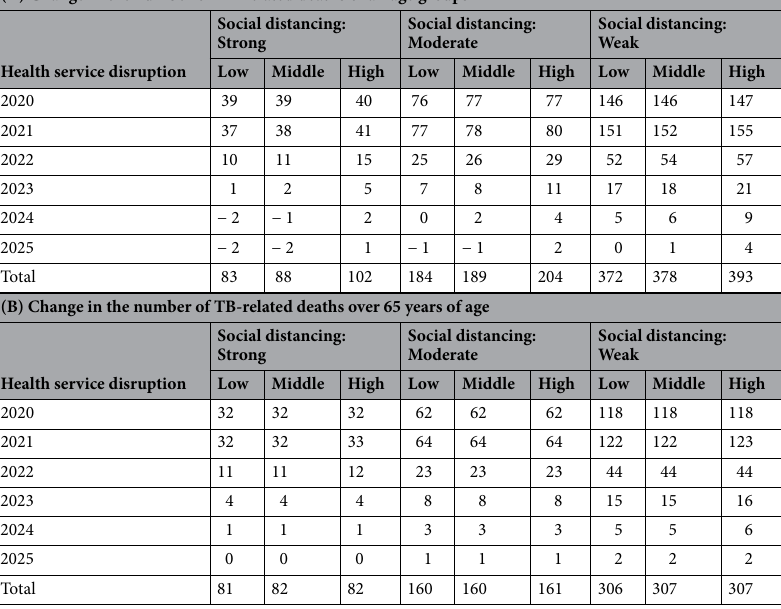
Table 4. Change in the number of TB-related deaths under each scenario of social distancing and health service disruptions compared to